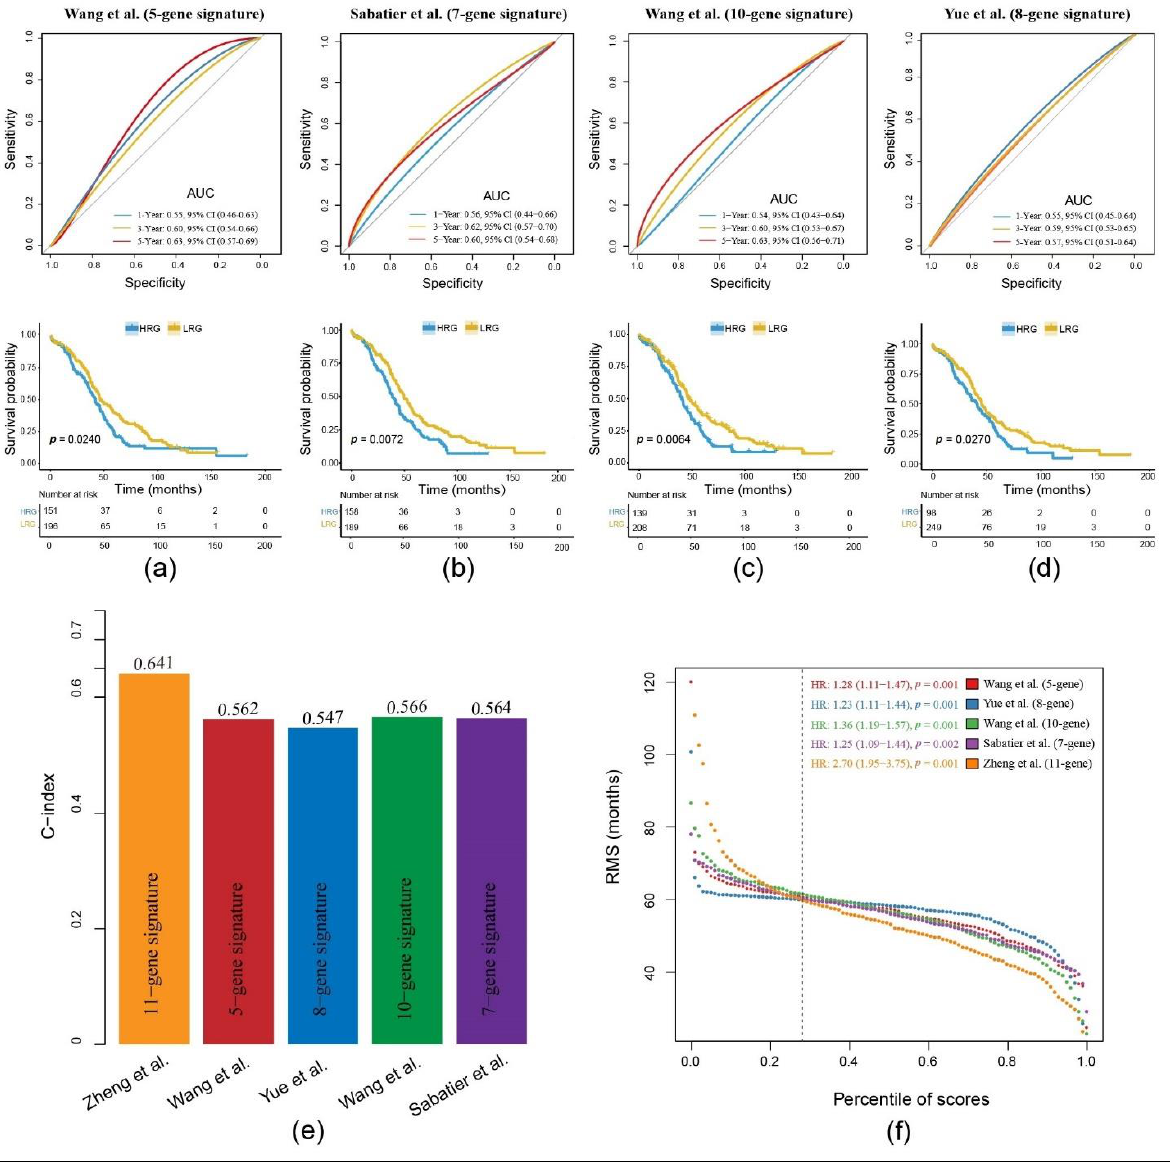
Figure 5. Comparison of the 11-gene risk model with other established models: ( a – d ) ROC and KM curves of four other published gene-signatures. ( e ) Concordance index (C-index) of the five prognostic risk models including our model, which has the highest C-index. ( f ) Restricted mean survival (RMS) time curve of all five prognostic risk models, revealing an overlap of 60